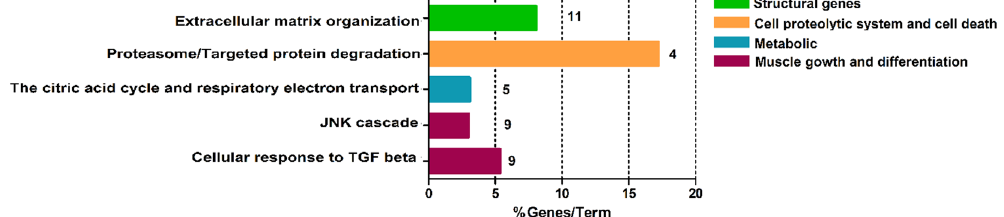
Figure 5. Gene-term enrichment analysis of mRNAs regulated by miRNAs in cardiac cachexia. Top canonical pathways affected in cardiac cachexia. Bars represent percentage of genes altered by miRNAs present in the data set compared to the total number of genes present in each selected pathway. In front of each bar is indicated the number of altered miRNAs in the pathway. Each color represents a major